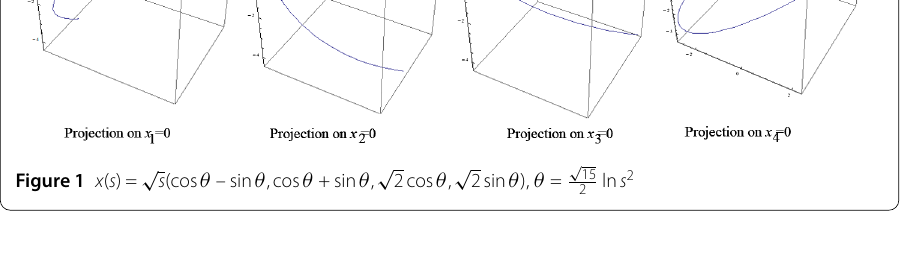
sinh s ,17cosh s + 35 3